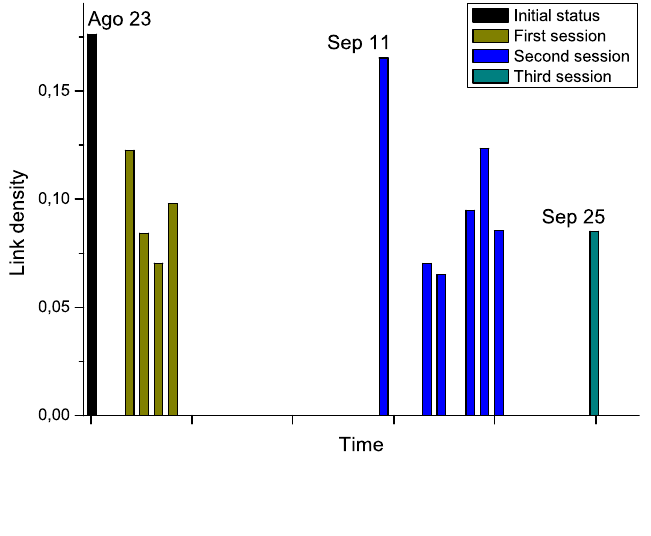
Figure 7. Evolution through time of the link density of networks representing a leukemia patient under chemotherapy